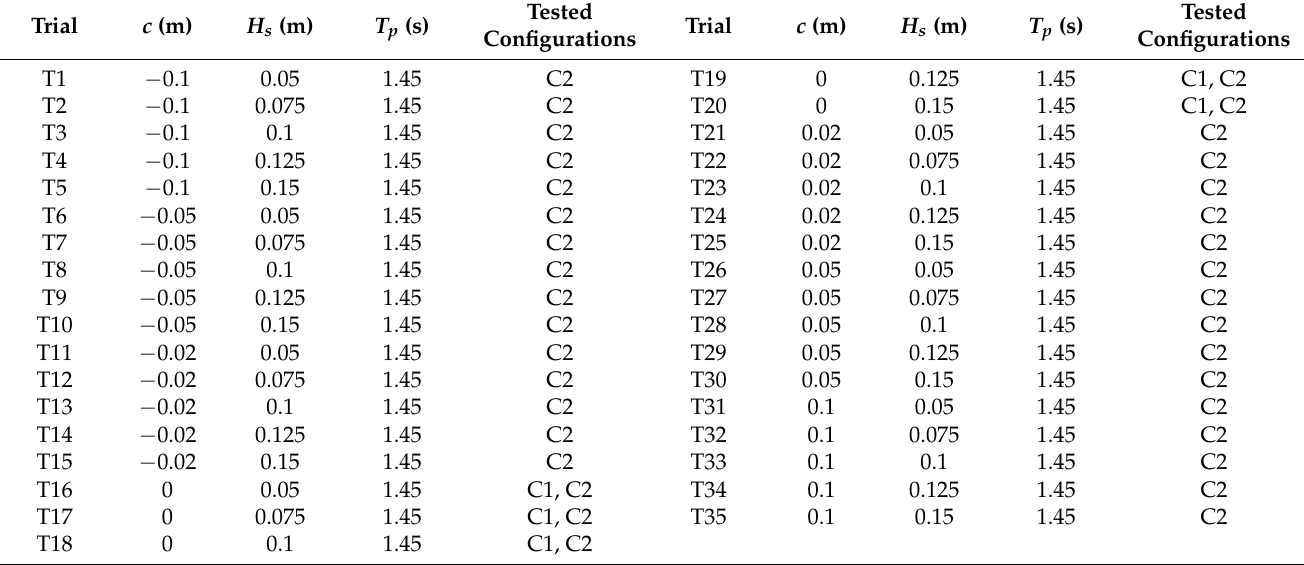
Table 1. Summary of conditions used in the wave